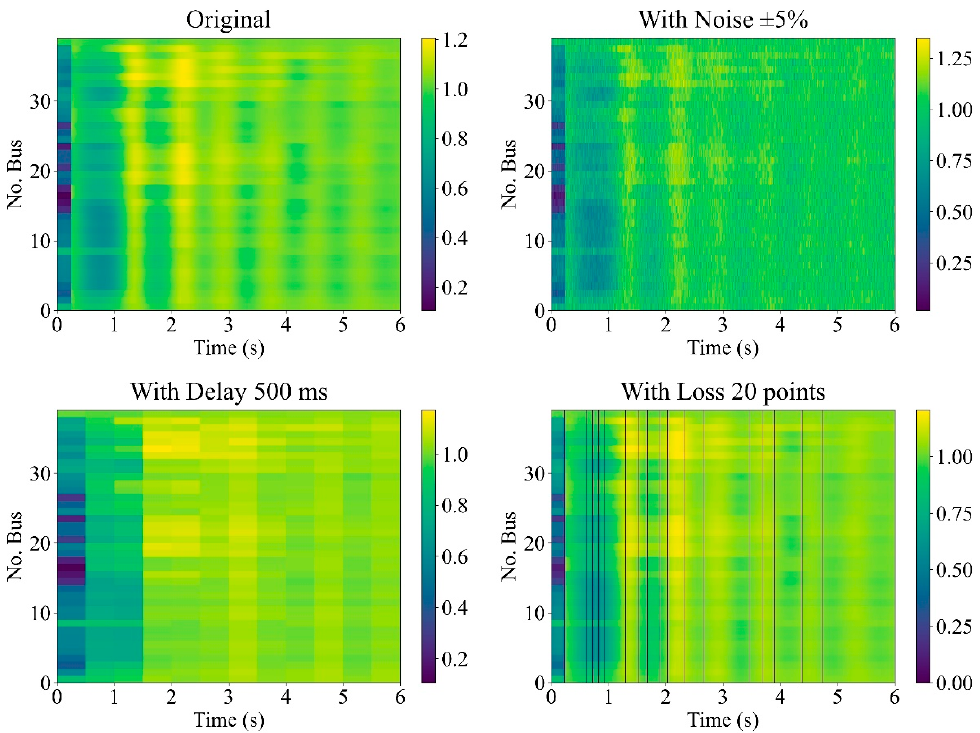
Figure 7. Colormap representation of voltage magnitude response in stable case.